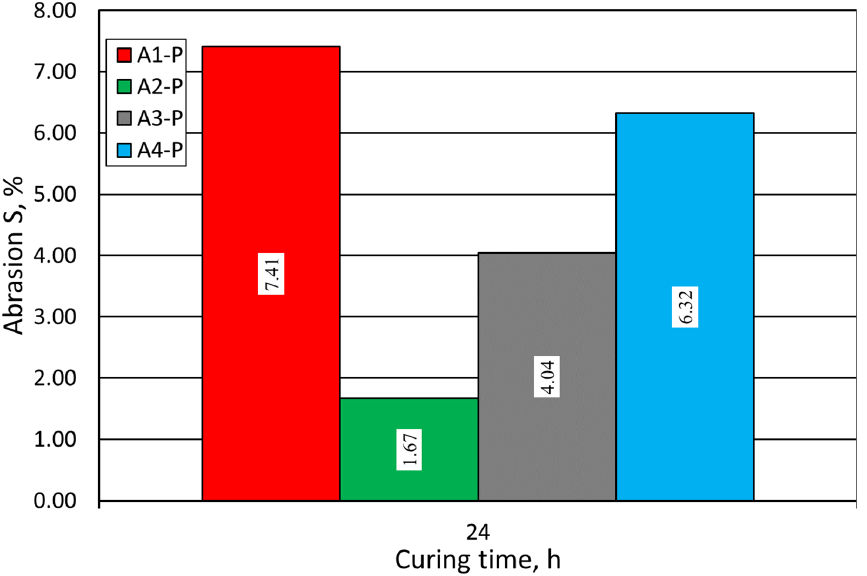
Figure 11. Molding sand S abrasion test carried out on Pioma Foundry (P) grain matrix.